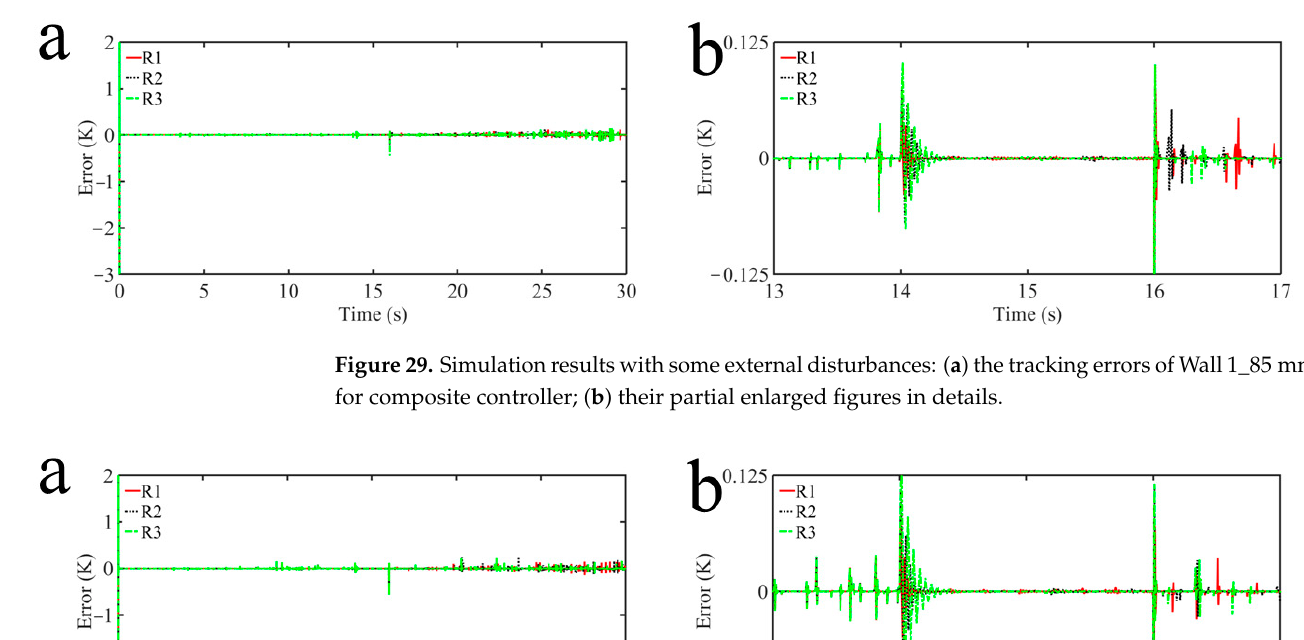
Figure 28. Simulation results with some external disturbances: ( a ) the tracking errors of Wall 1_45 mm for composite controller; ( b ) their partial enlarged figures in details.